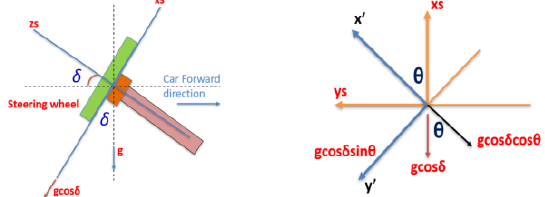
Figure 2. Steering wheel angle and steering inclination angle